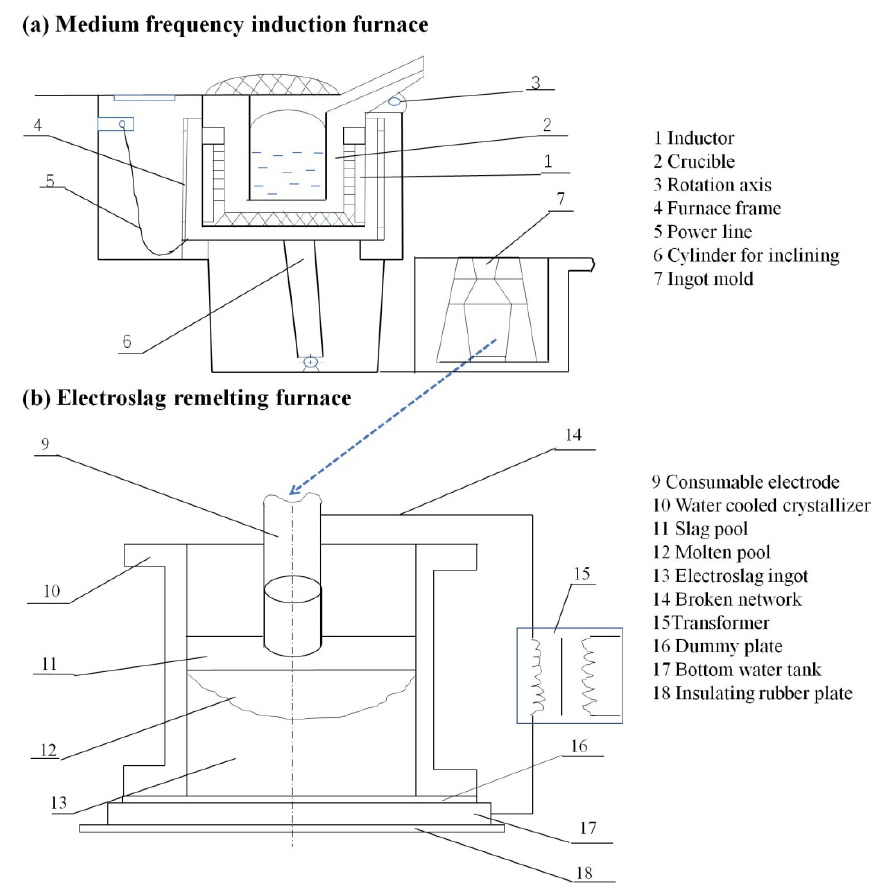
Figure 1. Schematics of medium-frequency induction furnace and electroslag remelting furnace.